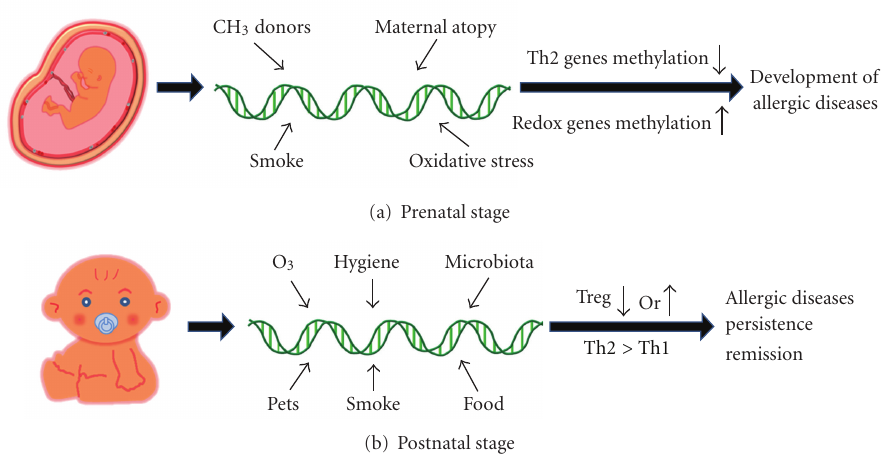
Figure 1: Mechanisms of pre- and postnatal environmental factors on the development of asthma. A number of prenatal factors such as maternal diet with methyl donors, maternal atopy, TSE, and oxidative stress could alter the epigenetic programming of Th2 and redox genes, resulting in the allergic sensitization and diseases (a). Additional postnatal environmental conditions such as pollution, secondhand TSE, pets exposure, infant diets and microbiota may modulate or drive the expression of Treg and/or Th1/Th2 genes resulting in skewed or balanced Th2 responses that contribute to persistence or remission of allergic diseases (b).